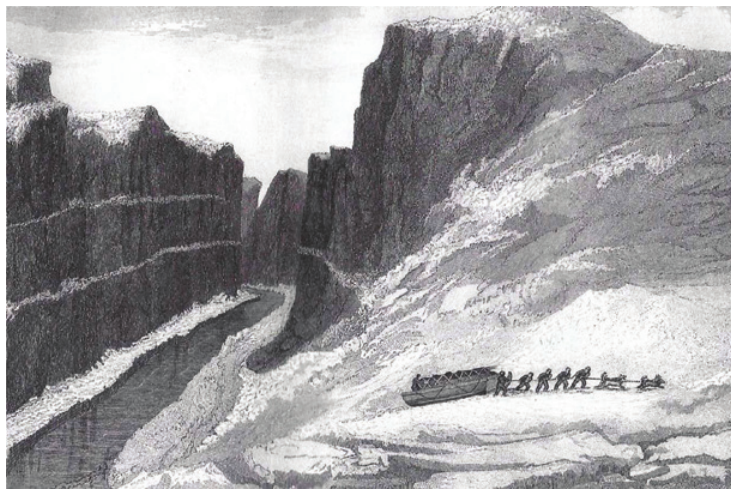
Figure 9. Sledge pulled by dogs and men . Source : Ross, Second Voyage ,